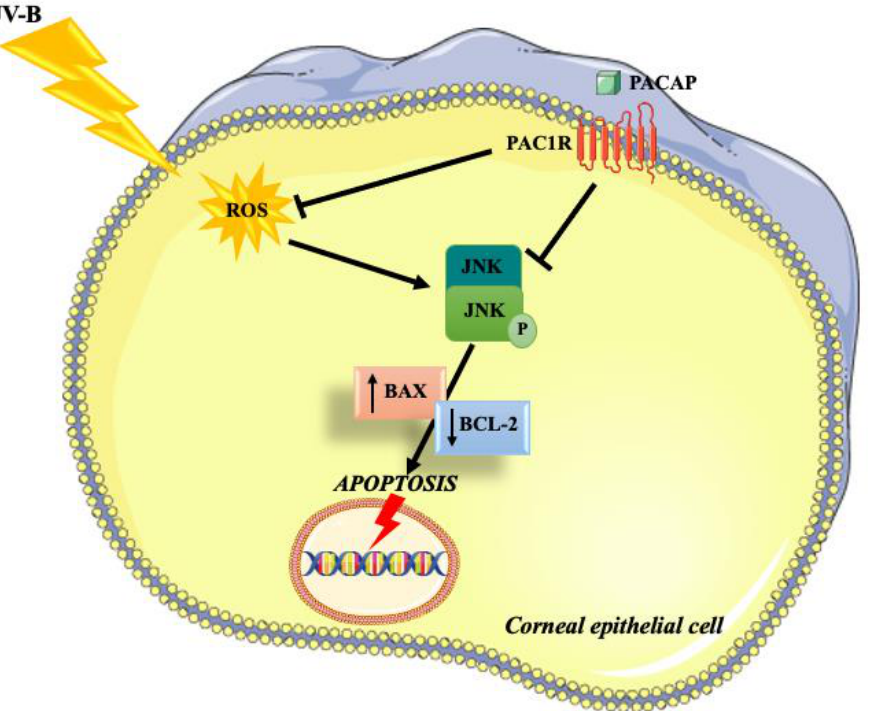
Figure 7. Schematic representation of the protective effects exerted by PACAP on corneal epithelium against UV-B-induced apoptosis via ROS/JNK pathway inhibition.